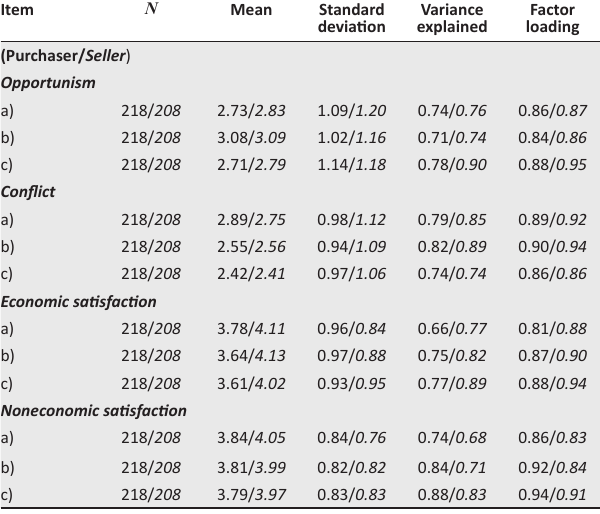
TABLE 4: Univariate